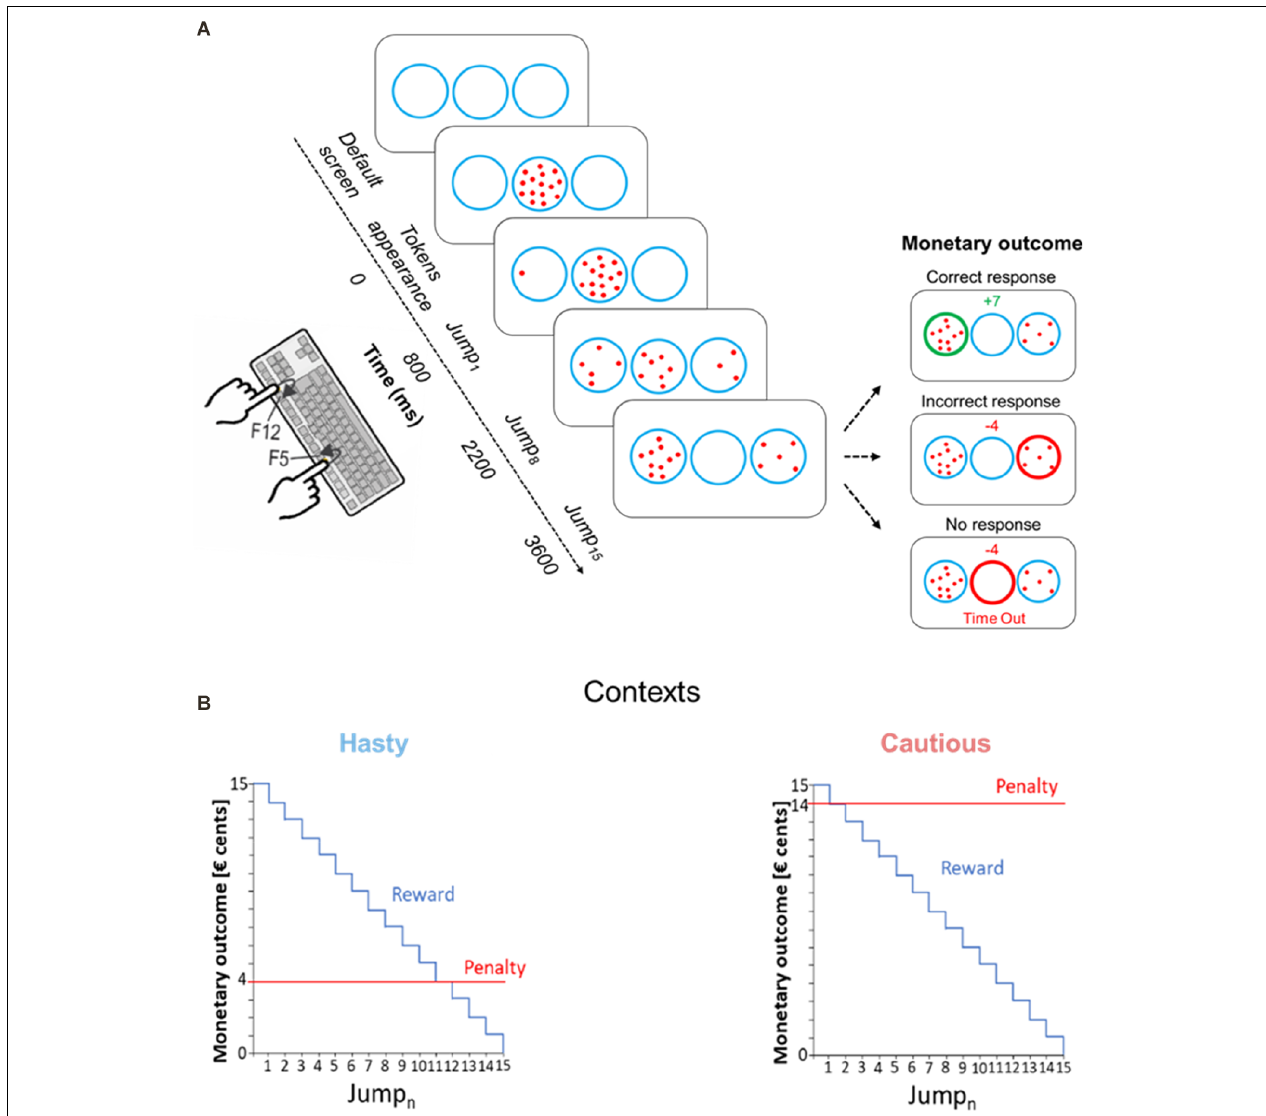
FIGURE 1 | (A) Schematic of the tokens task. In each trial, 15 tokens jumped one by one every 200 ms from the central circle to one of the lateral circles. The subjects had to indicate by a left or right index finger keypress (i.e., F12 and F5 keys, respectively) which lateral circle they thought would receive the majority of tokens at the end of the trial. For a correct response, the subjects won, in e cents, the number of tokens remaining in the central circle at the time of the response. Hence, the reward earned for a correct response decreased over time, as depicted in (B) . The right side of panel (A) depicts the monetary outcome in three exemplary cases. The upper inset represents the reward provided for a correct response between Jump 8 and Jump 9 , that is when seven tokens remain in the central circle at the moment the left circle is chosen; the middle inset represents the penalty for an incorrect response in the hasty context, fixed at − 4 cents; the lower inset shows the penalty in a “Time Out” trial (no response), fixed at − 4 cents, regardless of the context. For representative purposes, the “Time Out” message is depicted below the circles in this example, while it was presented on top of the screen in the actual experiment. (B) Contexts. Incorrect responses led to a fixed negative score, which differed depending on the context. In the hasty context (shown on the left), the penalty was low, equaling only 4 cents (see red line), promoting fast decisions. In contrast, in the cautious context (shown on the right), the penalty was high, equaling 14 cents, promoting thus slower decisions.